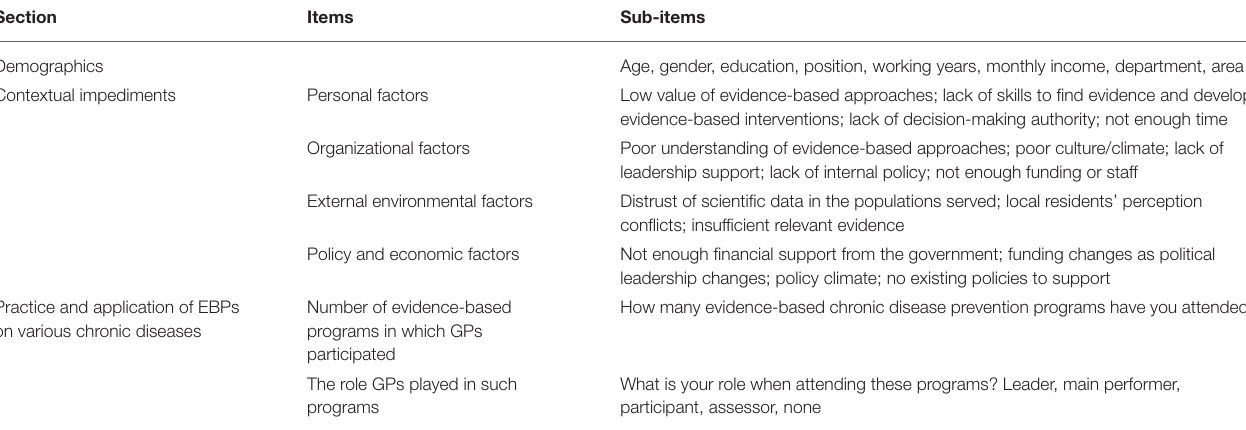
TABLE 1 | Description of the questionnaires.